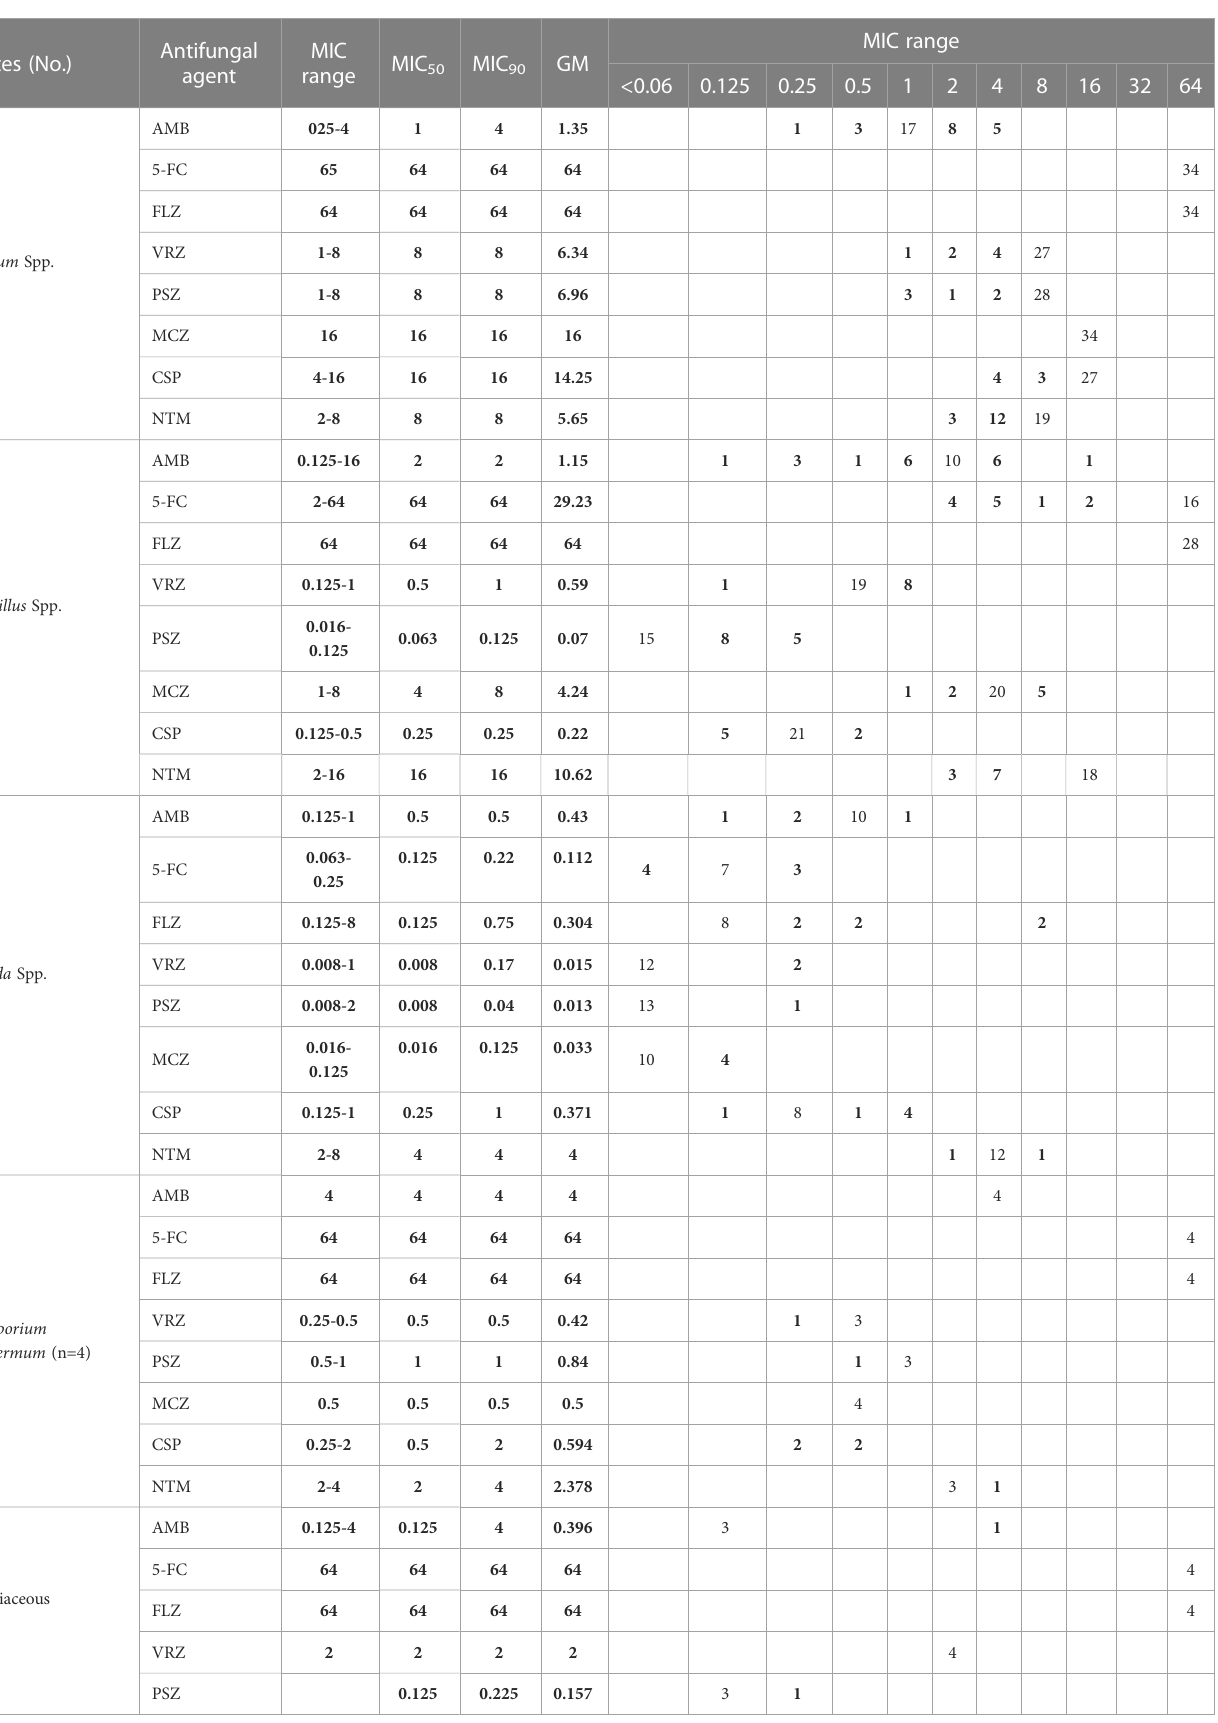
TABLE 5 Antifungal Susceptibility Pattern of assayed isolates.